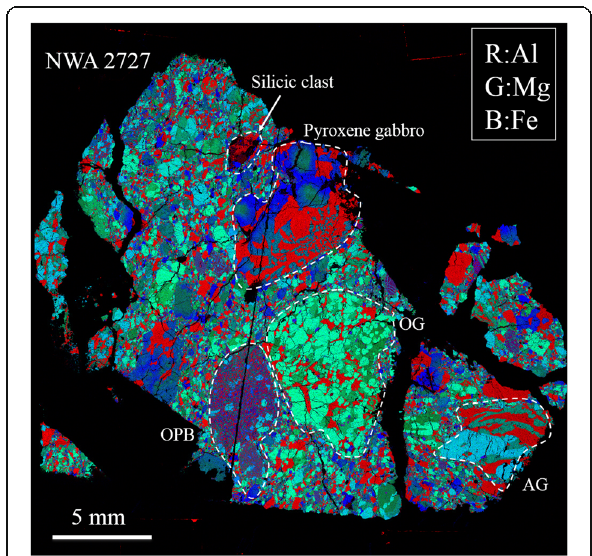
Fig. 1 False-color X-ray elemental image of NWA 2727 breccia modified after Kayama et al. (2018). Red, green, and blue (RGB) represent Al, Mg, and Fe, respectively. K α X-rays were used for all